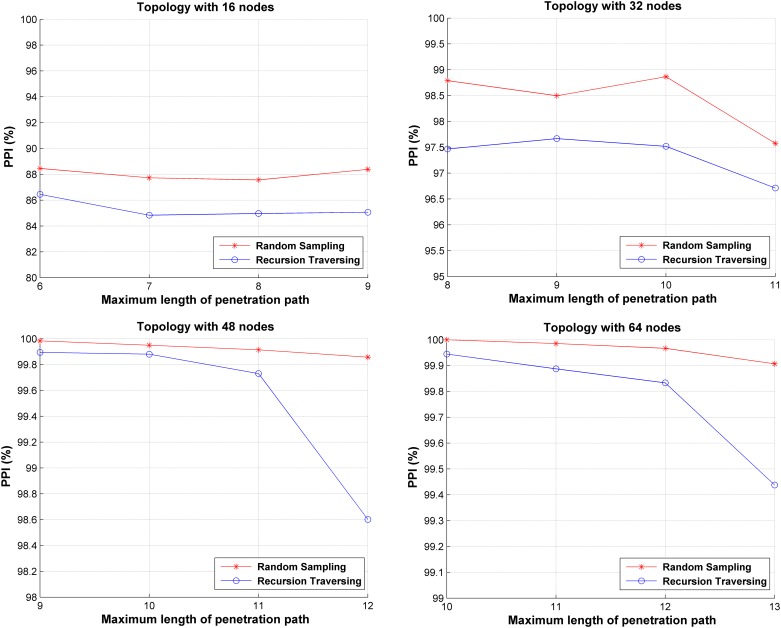
Comparison of PPI using recursive traversal and random sampling algorithm.